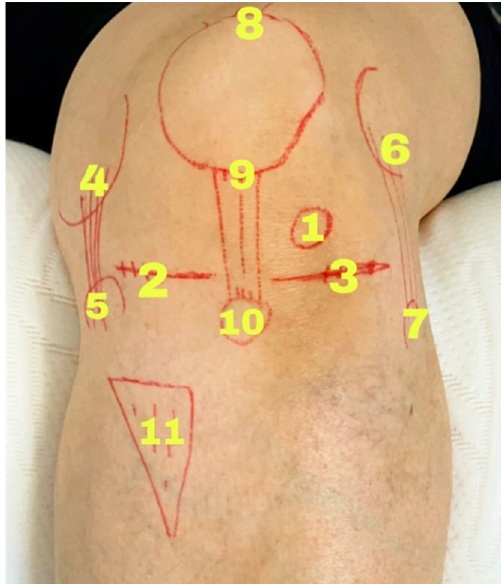
Figure 2. Periarticular injection sites of DPT and OT in the knee with osteoarthritis. (1: intraarticular injection site, periarticular injection sites: 2: medial region of coronary ligament, 3: lateral region of coronary ligament, 4: proximal region of medial collateral ligament and femur, 5: distal region of medial collateral ligament and tibia, 6: proximal region of lateral collateral ligament and femur, 7: distal region of lateral collateral ligament and head of the fibula, 8: quadriceps tendon region of patella, 9: proximal region of the patellar tendon, 10: distal region of the patellar tendon and tuberositas tibia, 11: tendon region of pes anserine).